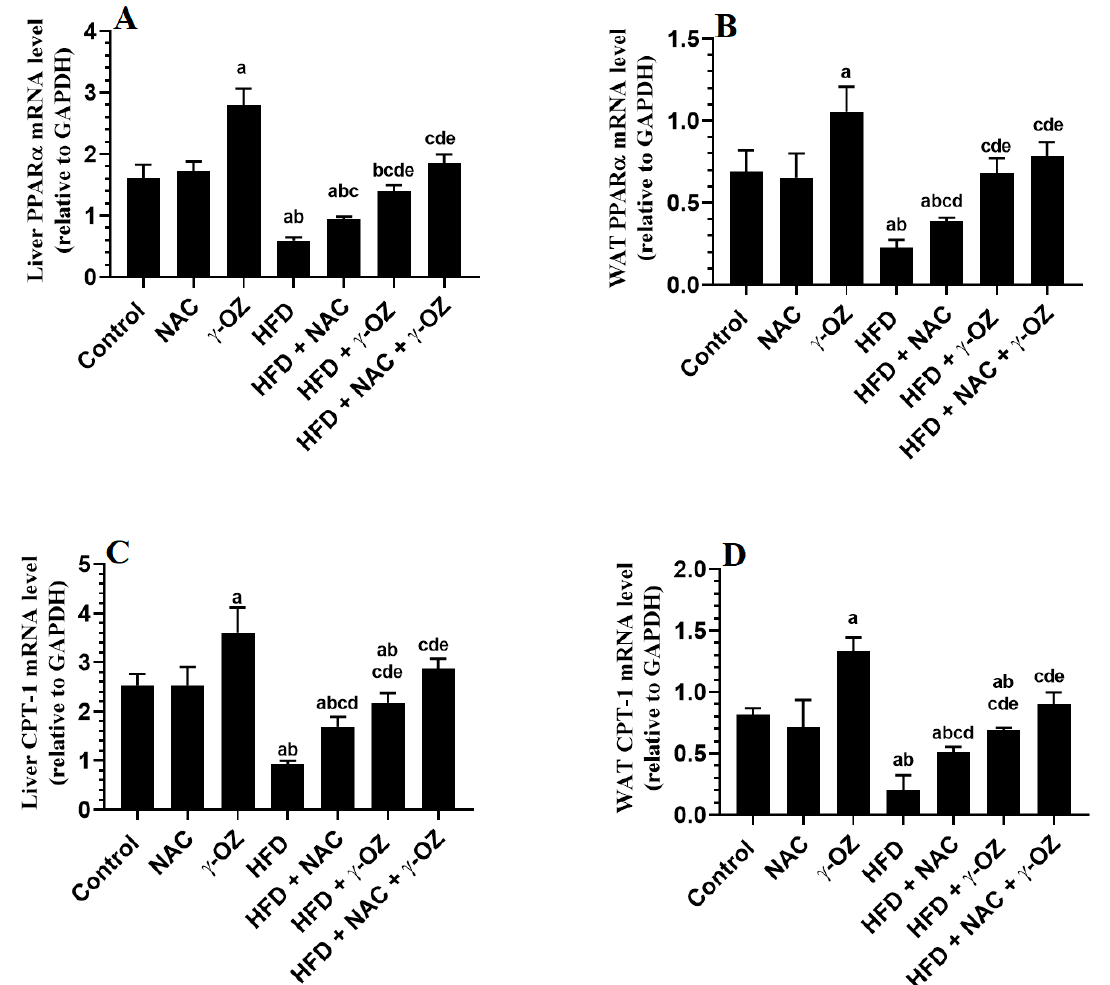
Figure 4. γ -Oryzanol (OZ) and N-acetylcysteine (NAC) and their combination downregulate the transcription of peroxisome proliferator-activated receptor alpha (PPAR α ) and carnitine palmitoyl transferase 1 (CPT1) in the livers ( A , C ) and white adipose tissue (WAT) ( B , D ) in all groups of rats. Data are presented as means ± SD (n = 8/group). The value of significance was determined at p < 0.05. a: significantly different as compared to the control group; b: significantly different as compared to the NAC-treated control rats; c: significantly different as compared to the γ -Oryzanol-treated rats; and d: significantly different as compared to the HFD-fed group; and e: significantly different as compared to the HFD + NAC-treated rats.